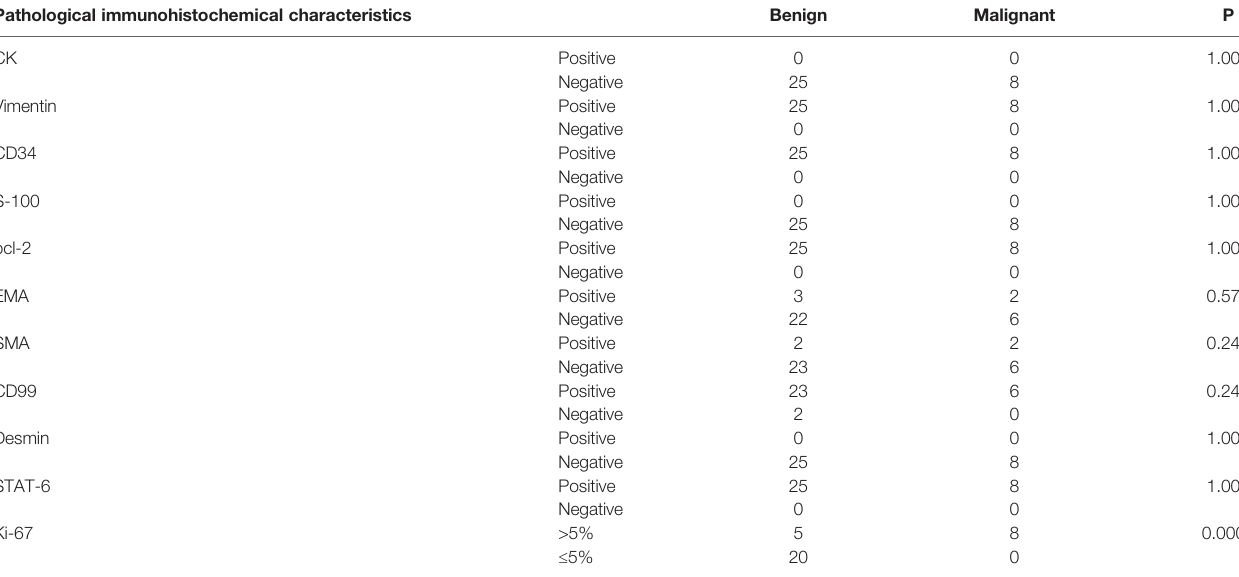
TABLE 5 | Pathological immunohistochemical characteristics of benign and malignant SFTP